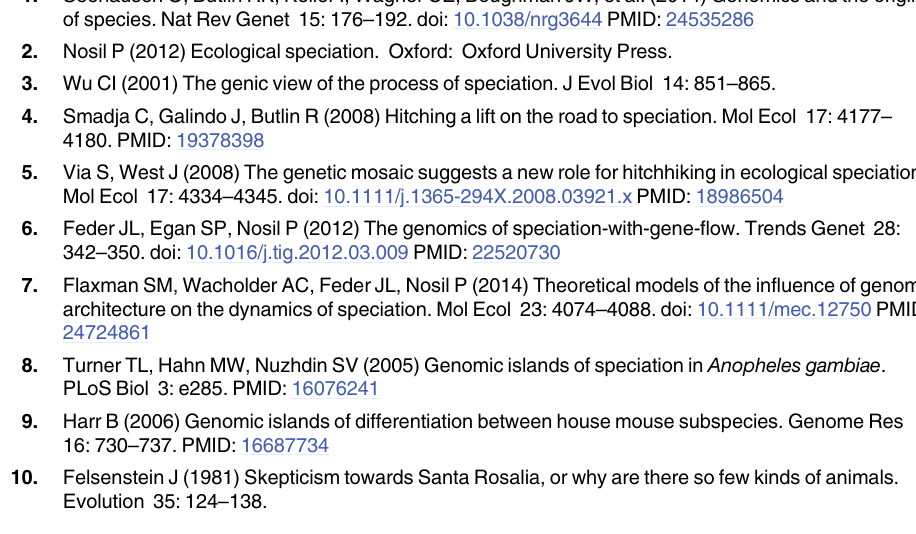
S1 Table. Genomic islands of differentiation (DIFF) and parallel differentiation (PAR- DIFF) and SNP counts. S2 Table. Associations between recombination rate and genomic islands of differentiation, parallel (IPD), non-parallel (IND) islands and SNP F S3 Table. Previously identified QTLs and outlier regions overlapping with genomic islands of parallel differentiation. S4 Table. Ensembl predicted genes overlapping with islands of parallel differentiation among Lake Constance lake and stream